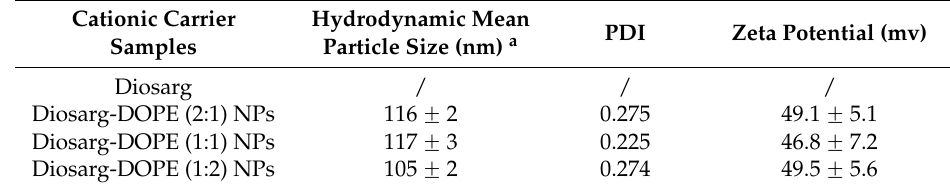
Table 1. Hydrodynamic average particle size, polydispersity (PDI) and zeta potential of the Diosarg-DOPE aggregates as obtained from the dynamic light scattering (DLS) measurements.